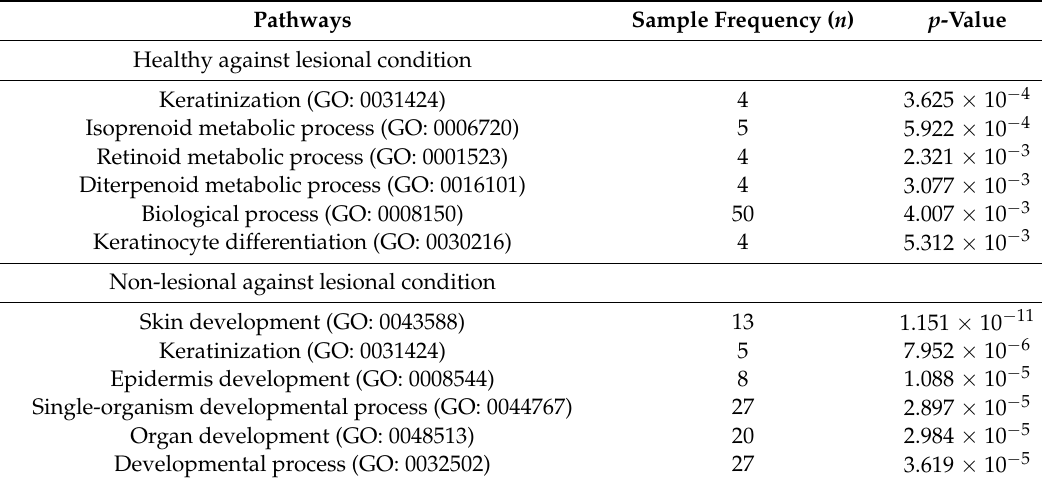
Table 2. Gene ontology